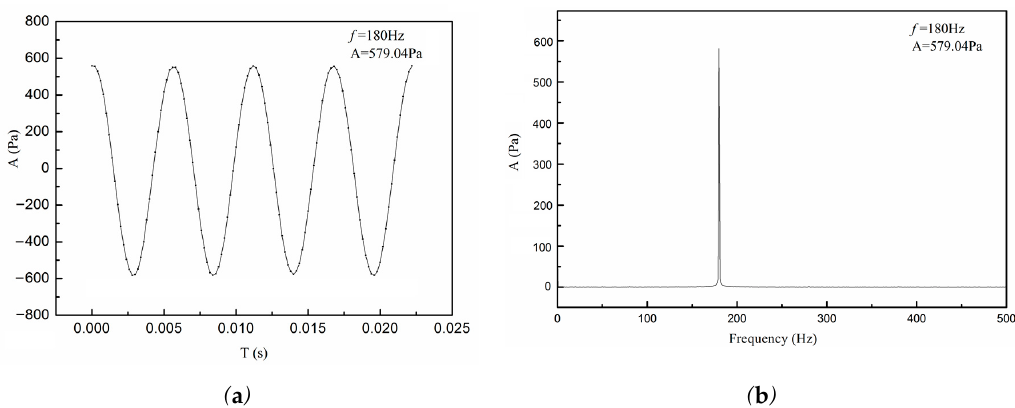
Figure 3. Acoustic pressure of the experimental system; ( a ): Time domain; ( b ): Frequency domain